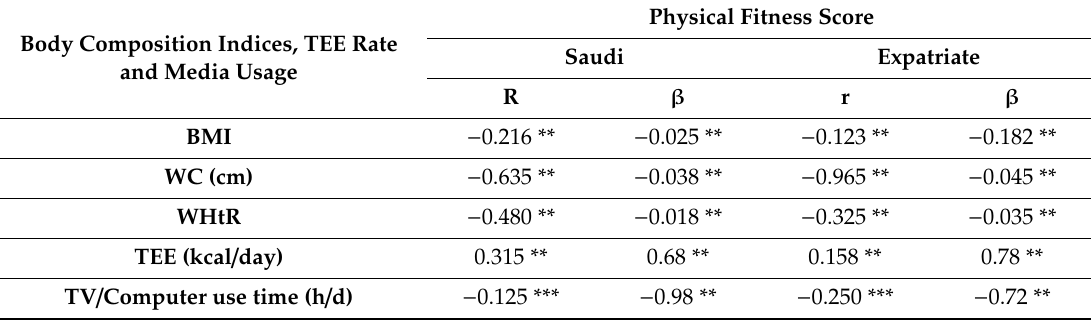
Table 4. Correlation between body composition indices, energy expenditure, media usage and physical fitness score among participants using partial correlation and multiple regression analysis.